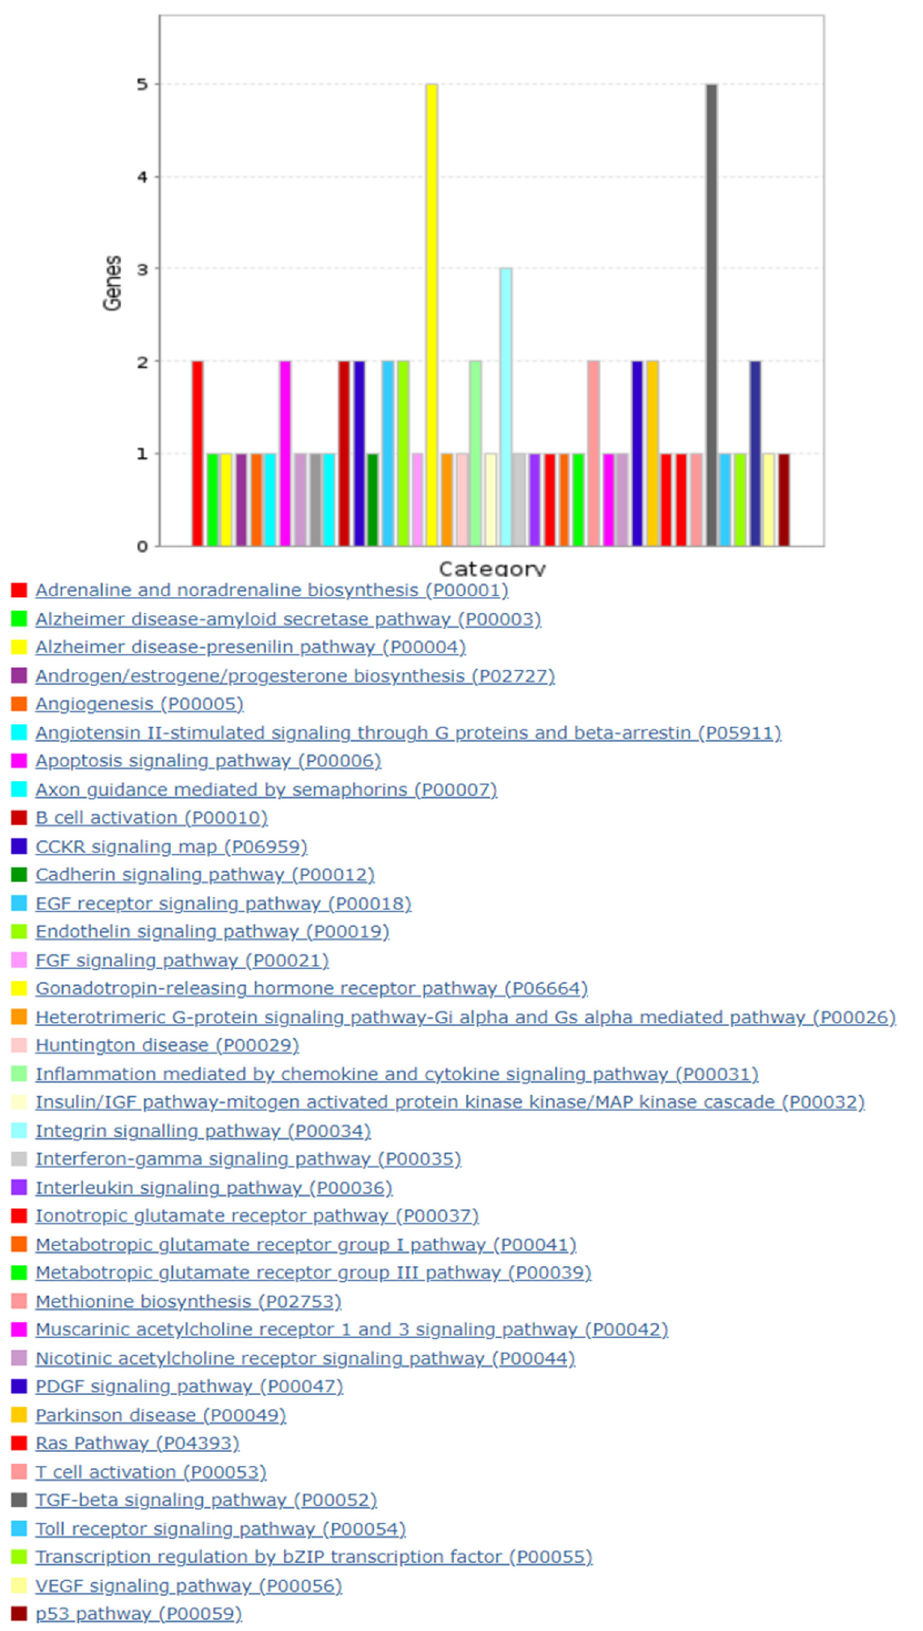
Figure 3. Functional Gene Ontology classification of bta-miR-215 pathway analysis of targeted genes.